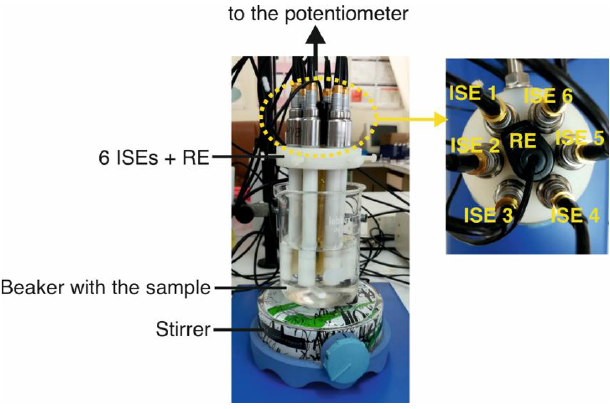
Figure 1. Illustration of the experimental